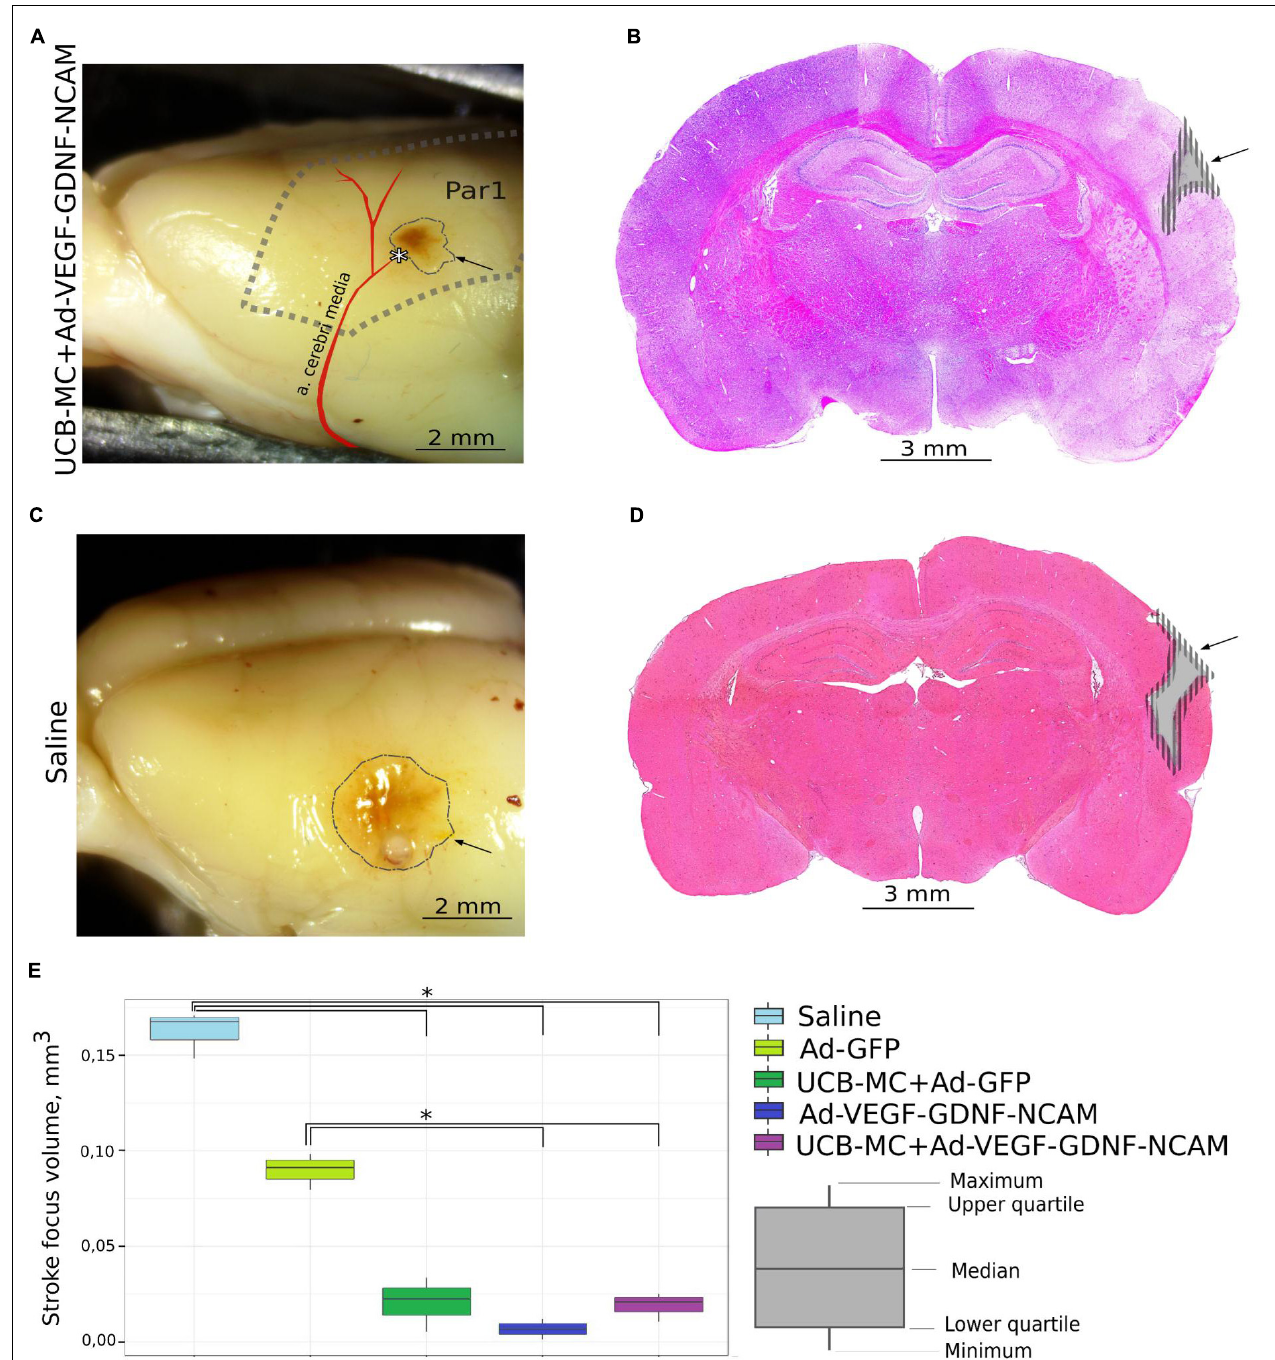
FIGURE 1 | Ischemic stroke 21 days after the distal permanent occlusion of the middle cerebral artery (MCA) in rats from control (Saline) and ex vivo (UCB-MC+AdVEGF-GDNF-NCAM) gene-treated groups. (A,C) The brain cortex infarction area. ∗ The site of the MCA occlusion. Par1, cortex parietals, area 1. (B,D) Frontal frozen section through the stroke area stained with hematoxylin and eosin. Arrow points to the brain cortex infarction in the left hemisphere. (E) Morphometric analysis of cerebral infarction volume. Data are visualized using box plots. ∗ Difference between experimental groups, p < 0.05.